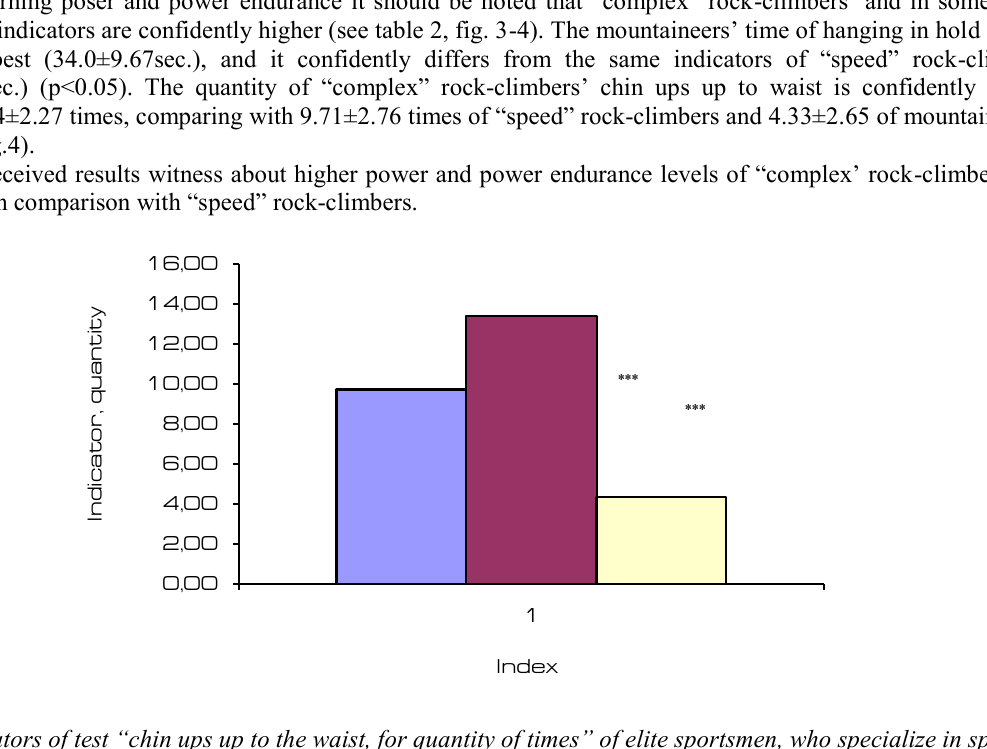
Fig.3. Indicators of test “chin ups up to the waist, for quantity of times” of elite sportsmen, who specialize in speed rock-climbing (n=10), complex rock-climbing (n=10) and mountaineering (n=6): Indicator, quantity - chin ups up to the waist, for quantity of times *** - differences are confident at